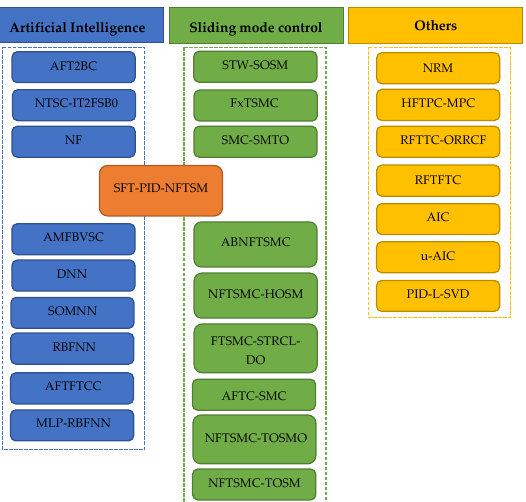
Figure 10. Proposed breakdown of fault-tolerant control system methods used in manipulators. All abbreviations of the control methods and their references to the literature are in the text above and in Table 1